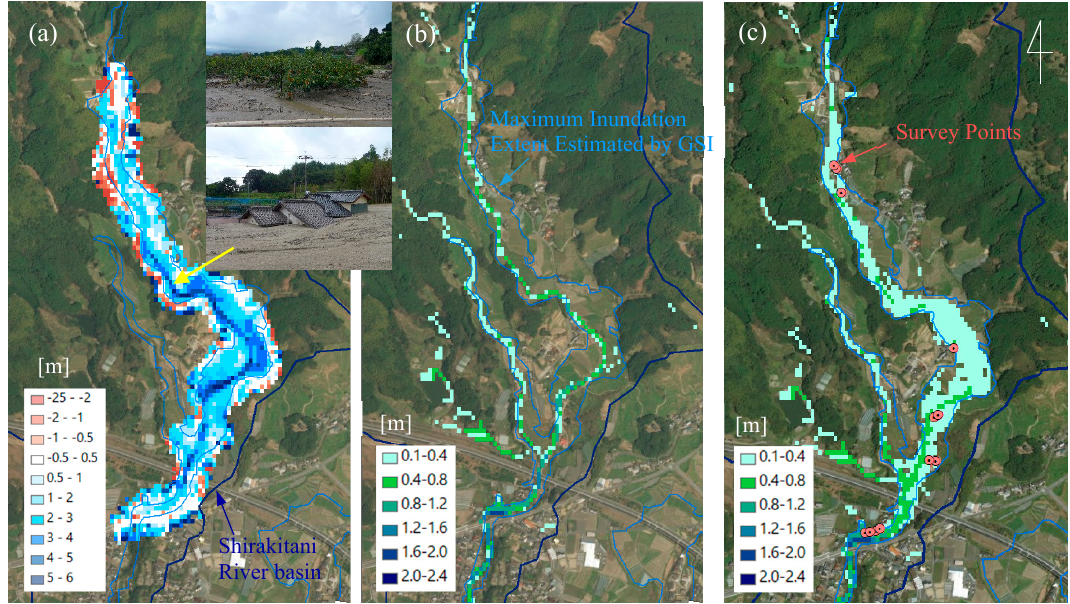
Figure 12. ( a ) RRI model calibration with observed dam inflow at Terauchi Dam, ( b ) simulated water depths at the downstream of Shirakitani River.